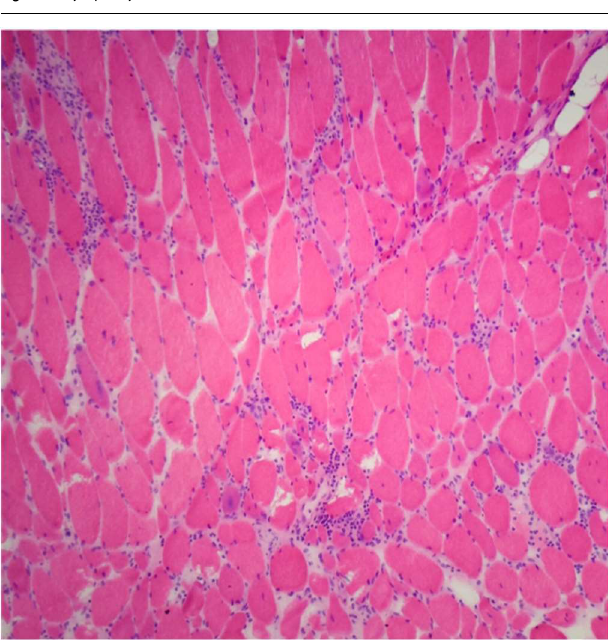
Figure 2. Lymphocytic Infiltrate in Muscle Tissue.